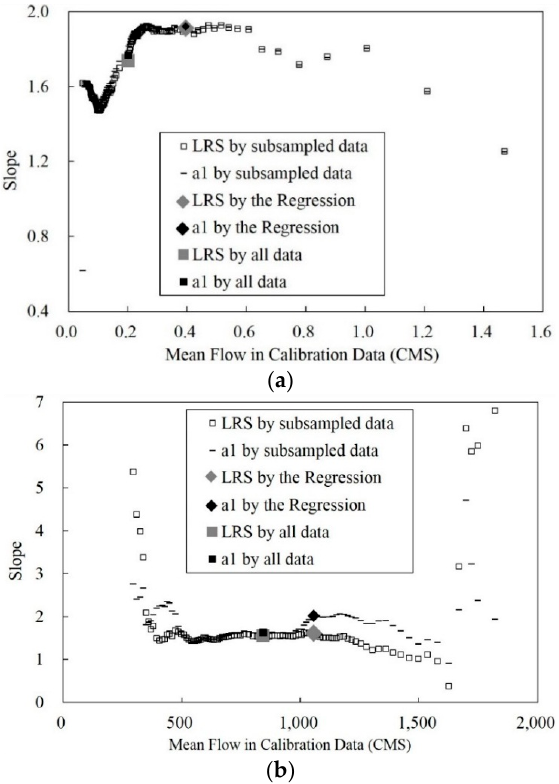
Figure 4. Comparison of slopes from linear regression formula (LRS in Equation (7)) and calibrated LOADEST model ( a 1 in Equation (4)): ( a ) USGS station number 02119400; ( b ) USGS station number 06486000.